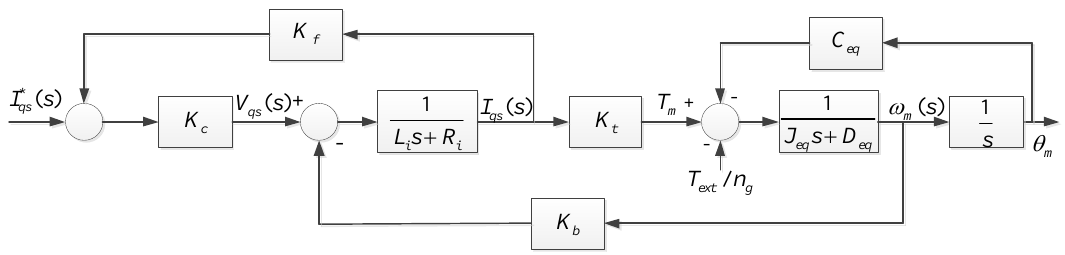
Figure 8. Block diagram of alternating current (AC) induction motor.